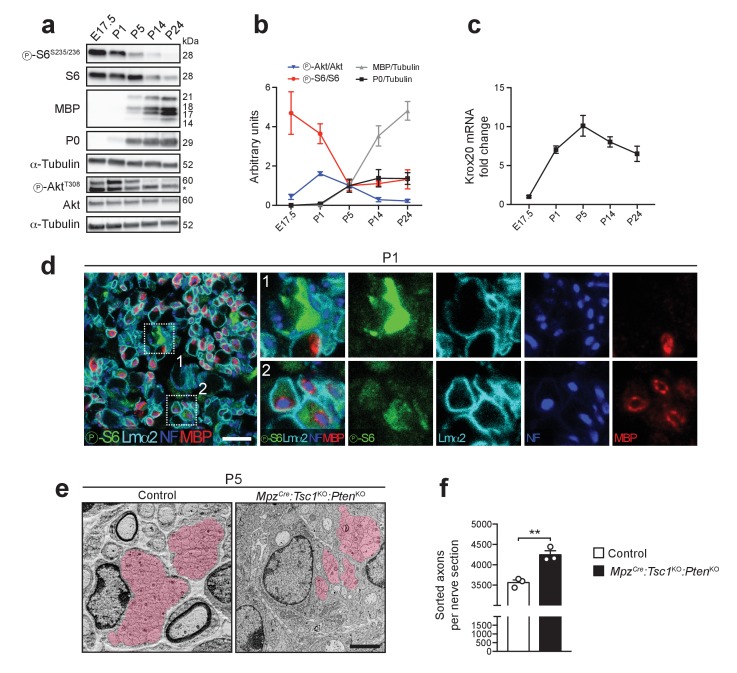
Akt and mTORC1 activities are high before onset of myelination and decline as myelination proceeds.(a) Western blot analysis of wild-type sciatic nerves (n = 3 mice/time point; for E17.5, three pools of sciatic nerves were used). Asterisk: Unspecific band. (b) Quantification referring to a, with P5 average set to 1. Symbols: Mean; error bars: s.e.m. (c) qRT-PCR from wild-type sciatic nerves. Transcript levels relative to E17.5, after normalization to α-tubulin. Symbols: Mean; error bars: s.e.m. (n = 6 mice at E17.5, n = 3 mice at P5, n = 4 mice for other time points). (d) Confocal microscopy images of immunostained sciatic nerve cross sections from P1 wild-type mice (n = 4 mice). Insets 1 and 2 show cells strongly or weakly positive for phospho-S6, in contact with axons, and surrounded by a basal lamina. Lmα2: laminin-α2. NF: neurofilament. MBP: myelin basic protein. Scale bar: 10 μm. (e) Electron micrographs of P5 control and MpzCre:Tsc1KO:PtenKO sciatic nerves. Area covered by bundles of unsorted axons highlighted in red (n = 3 mice/genotype). Scale bar: 2 μm, refers to whole panel. (f) Sorted axons per sciatic nerve cross section from P5 control and MpzCre:Tsc1KO:PtenKO mice. Bar height: Mean; error bars: s.e.m. (n = 3 mice/genotype, two-tailed unpaired Student’s t-test, t(4) = 5.806, p=0.0044). **p<0.01.10.7554/eLife.29241.014Figure 4—source data 1.Timeline of PI3K-Akt-mTORC1 activity in mouse nerve development (data referring to Figure 4b)10.7554/eLife.29241.015Figure 4—source data 2.Timeline of Krox20 expression in mouse nerve development (data referring to Figure 4c)